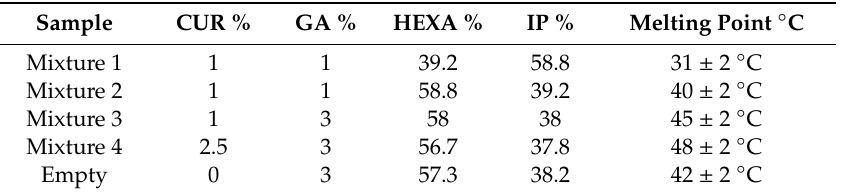
Table 1. Lipid mixture